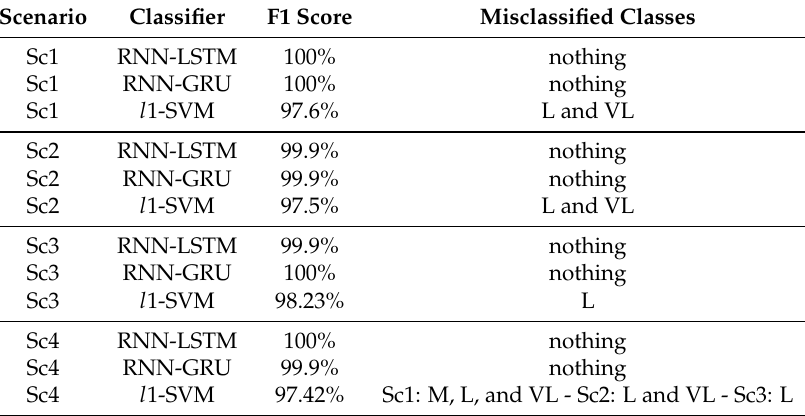
Table 3. Detection accuracy of the proposed approach (token-based feature